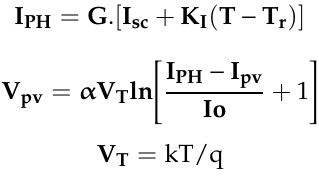
Figure 1. Single-diode model.